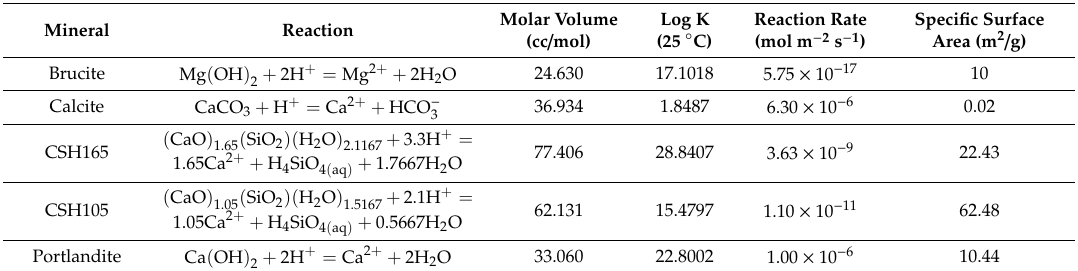
Table A1. Thermodynamic, molar volume and kinetic rate data for primary and secondary cement minerals. All data is taken from JAEA-TDB v1.07